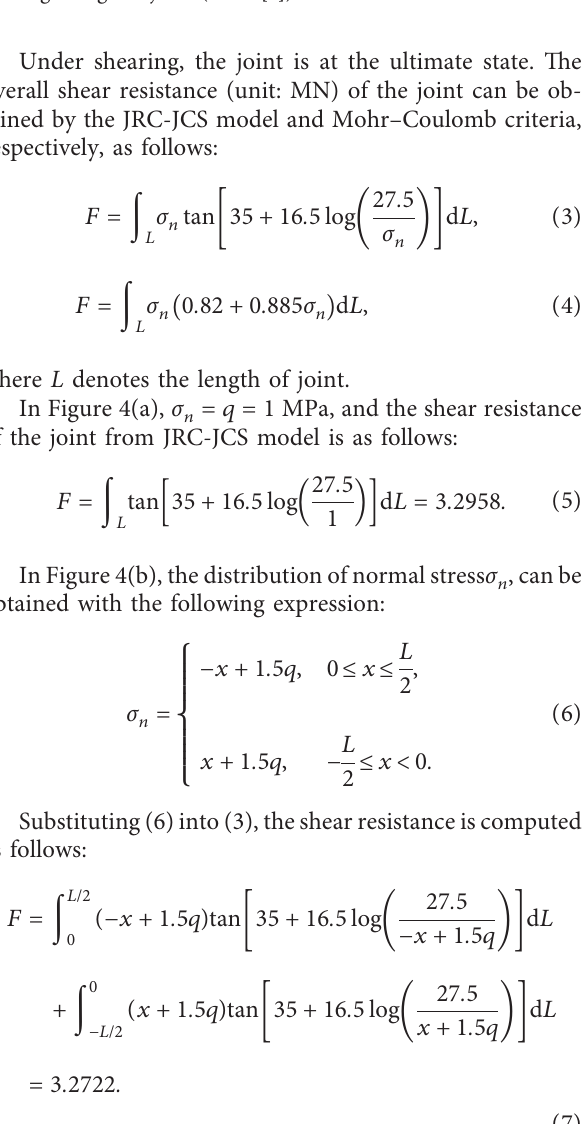
Figure 2: Two failure mechanisms of shearing along the joint (from [1]).